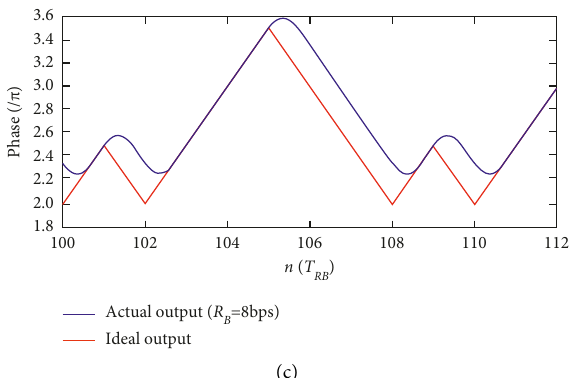
Figure 11: Simulation results of the phase and spectrum affected by different symbol rates (a) R ( Δ ( f ) � 1Hz); (c) RB � 8 bit/s ( Δ ( f ) � 2Hz).